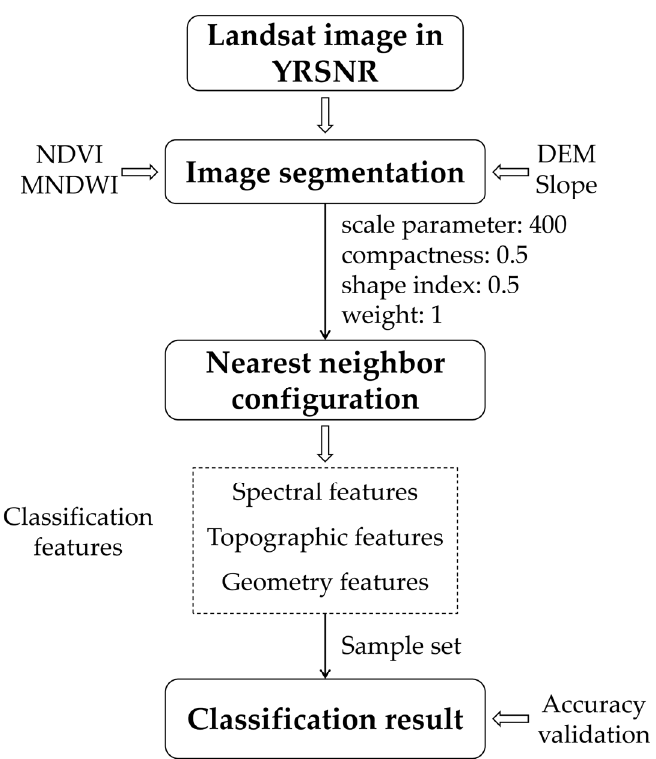
Figure 2. A flow chart of object-oriented wetland classification.